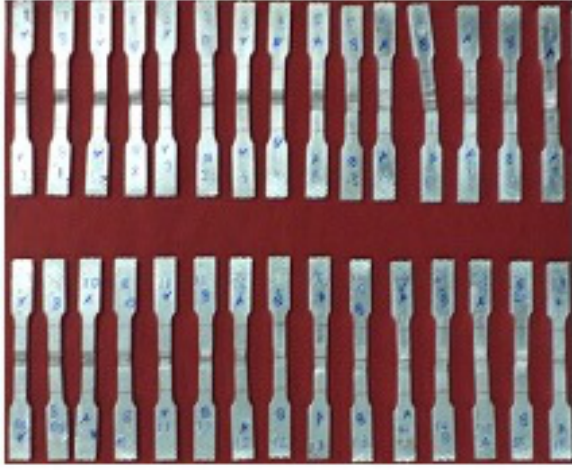
Figure 6: Photograph of tensile specimens (After